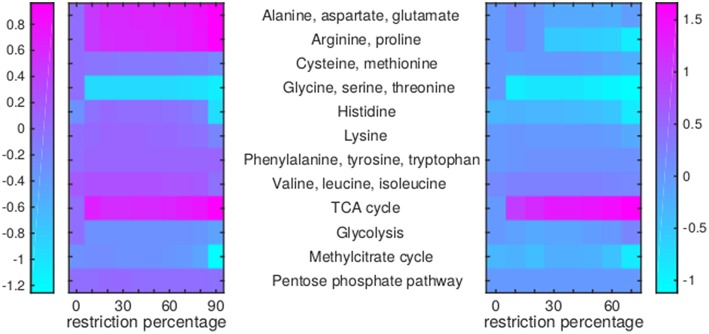
Flux rerouting through amino acid metabolism and major pathways upon application of drugs. Heat maps indicate a predicted relative increase (pink) or decrease (light blue) through various pathways upon the application of a variety of drugs. The logarithm of the sum of all absolute fluxes is given per pathway (values are indicated in the color bars on either side), so information on directionality is not comprised. The x-axis indicates the percentage of restriction of the drug-affected reaction(s). Left: average of BTZ043, cycloserine/terizidone, ethambutol, ethionamide/propionamide, and isoniazid; Right: TMC207.